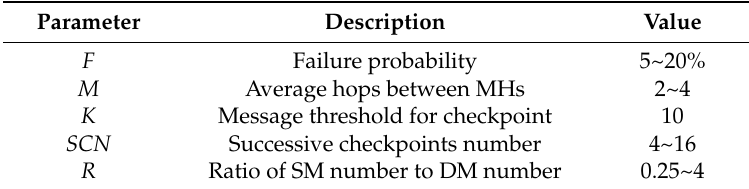
Table 1. Parameters for